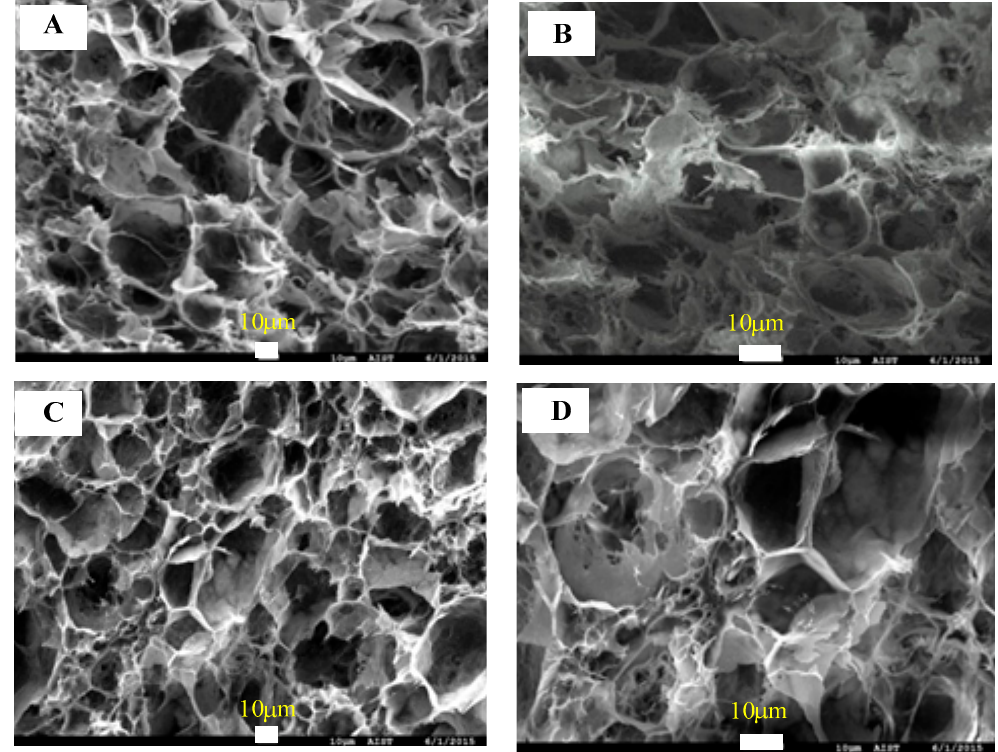
Figure 2. Field-emission scanning electron microscopy (FE-SEM) images of cellulose aerogel 2 wt.% ( a–b ) and cellulose aerogel 1.5 wt.% ( c–d ).